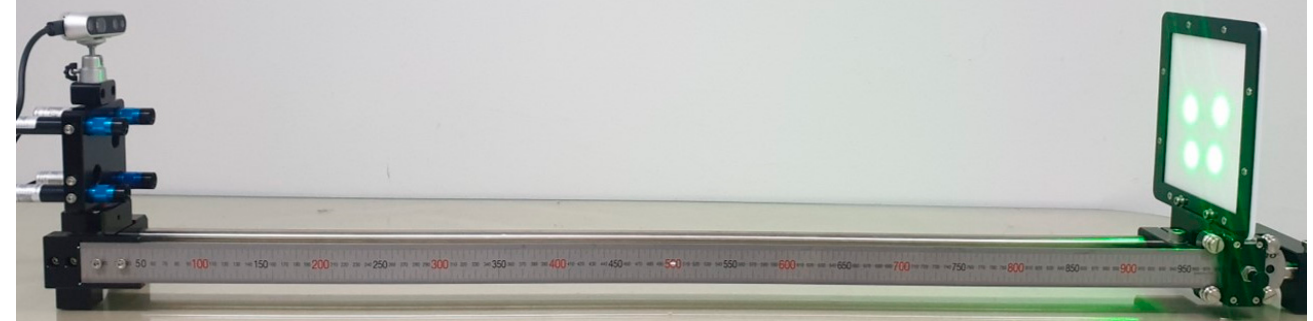
Figure 5. Laser pose calibration with a specially jig module.